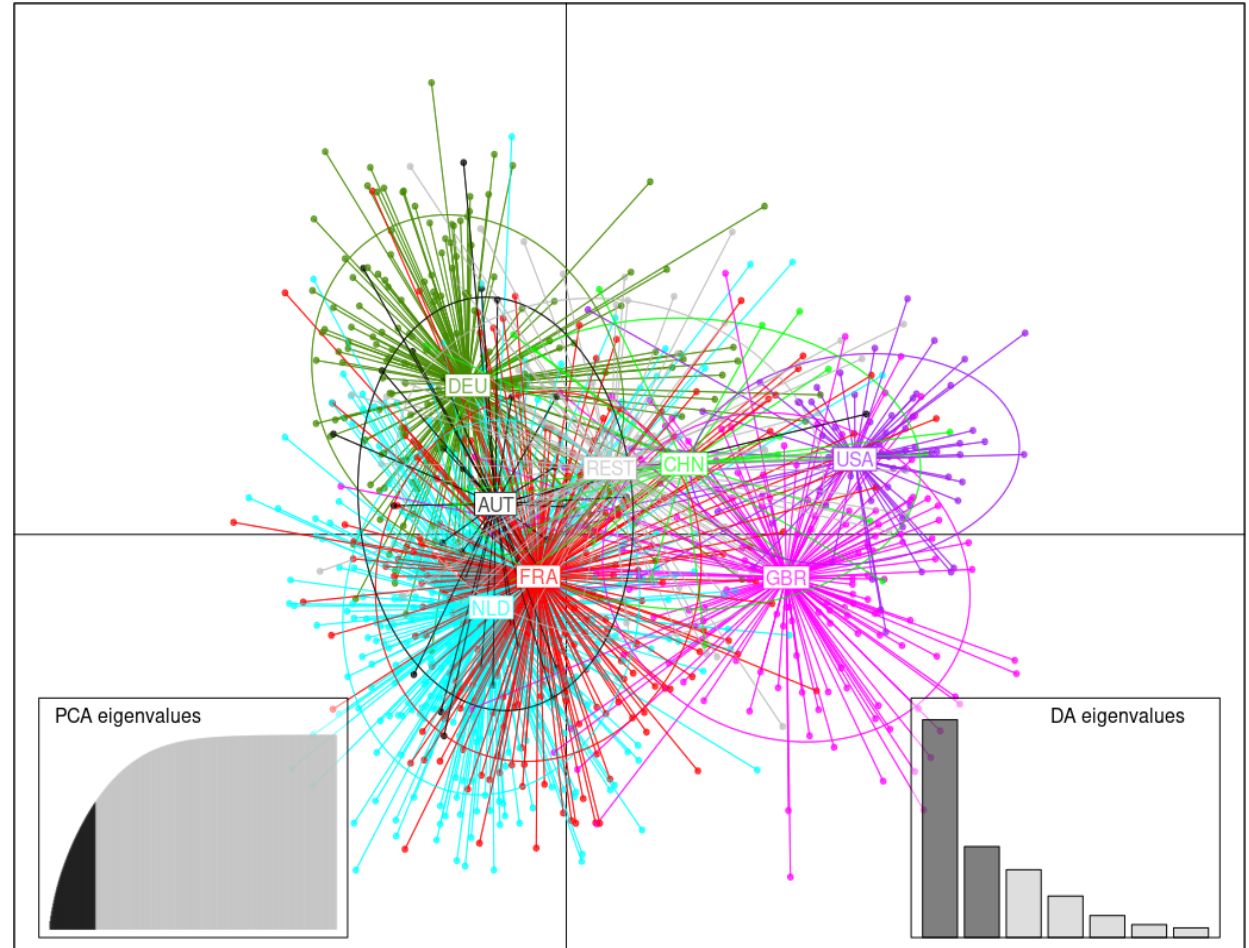
Figure 5. Discriminant analysis of principal components (DAPC) for the germplasm of 1219 potato accessions originating in various countries. The axes correspond to the first two linear discriminants (LD). Each ellipse represents a country cluster: Austria (AUT), China (CHN), France (FRA), Germany (DEU), the Netherlands (NLD), United Kingdom (GBR), United States (USA), and Rest (REST), and each point represents an individual.